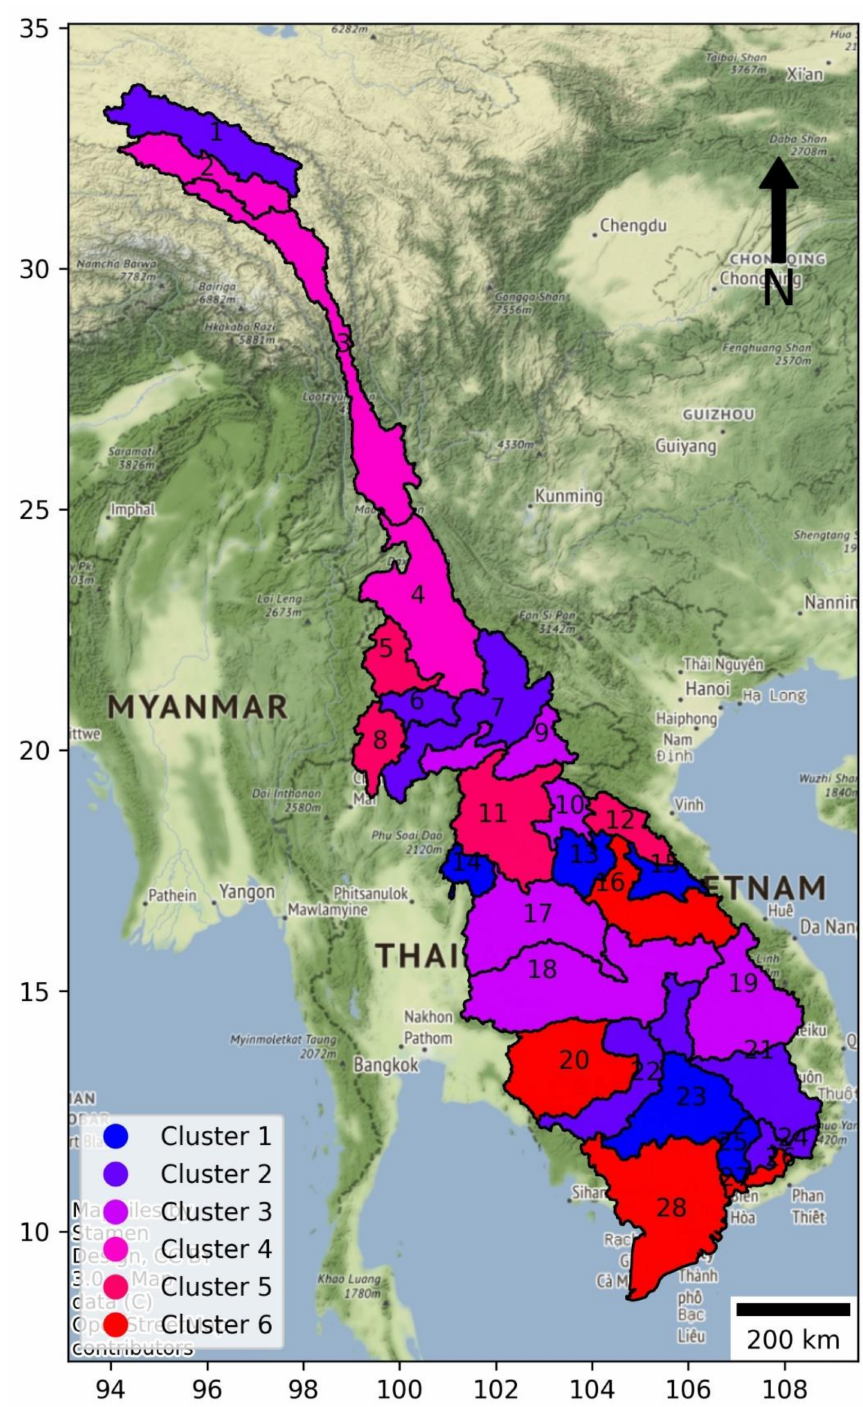
Figure 11. Clustering time